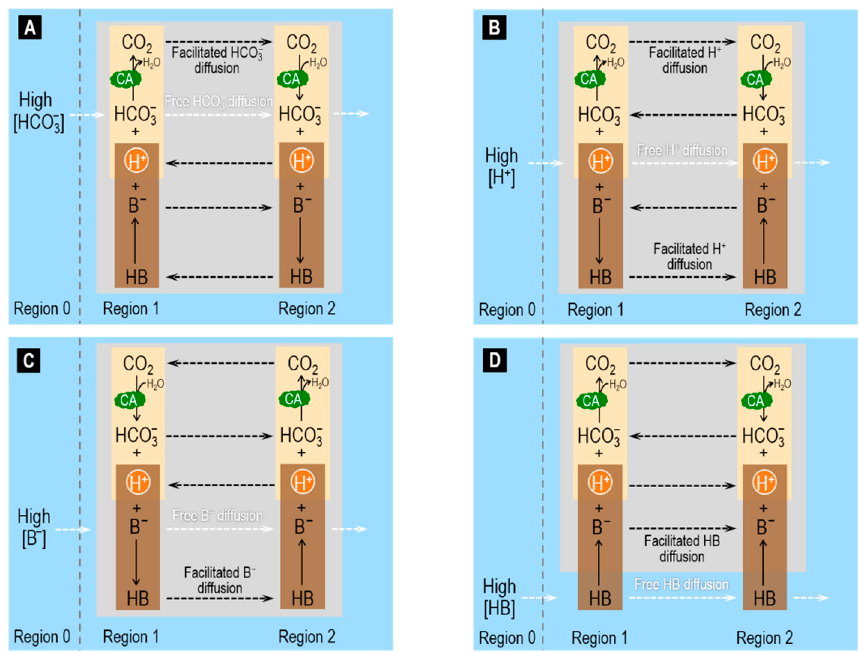
Figure 2. Schematic of the reaction and diffusion processes involved in facilitated diffusion of: HCO 3 − ( A ); H + ( B ); B − ( C ); and HB ( D ). We set up the four examples as in Figure 1, except that the component that we add to Region 0 is different. At time zero, we establish a gradient for HCO 3 − in ( A ) from Region 0 (high [HCO 3 − ]) to Region 1 (low [HCO 3 − ]), for H + in ( B ), for B − in ( C ), and for HB in ( D ). The solid arrows identify reactions, and the dashed arrows identify free solute diffusion. For details, see text. CA, carbonic anhydrase.